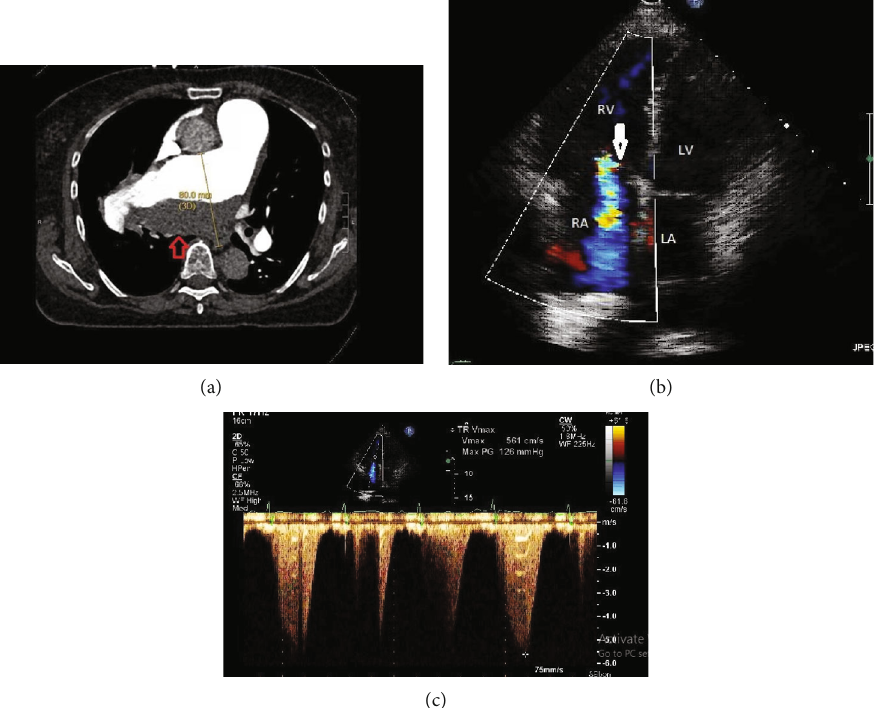
Figure 3: (a) CTA chest showing right pulmonary artery aneurysm measuring 80 mm in the greatest dimension with laminated thrombus in the aneurysmal sac (red arrow). (b) Transthoracic echocardiogram apical four-chamber view showing dilated RV, severe TR (white arrow), and systolic septal fl attening consistent with RV pressure overload. (c) Extremely elevated estimated PA systolic pressure measurements to 134 mmHg indicating severe